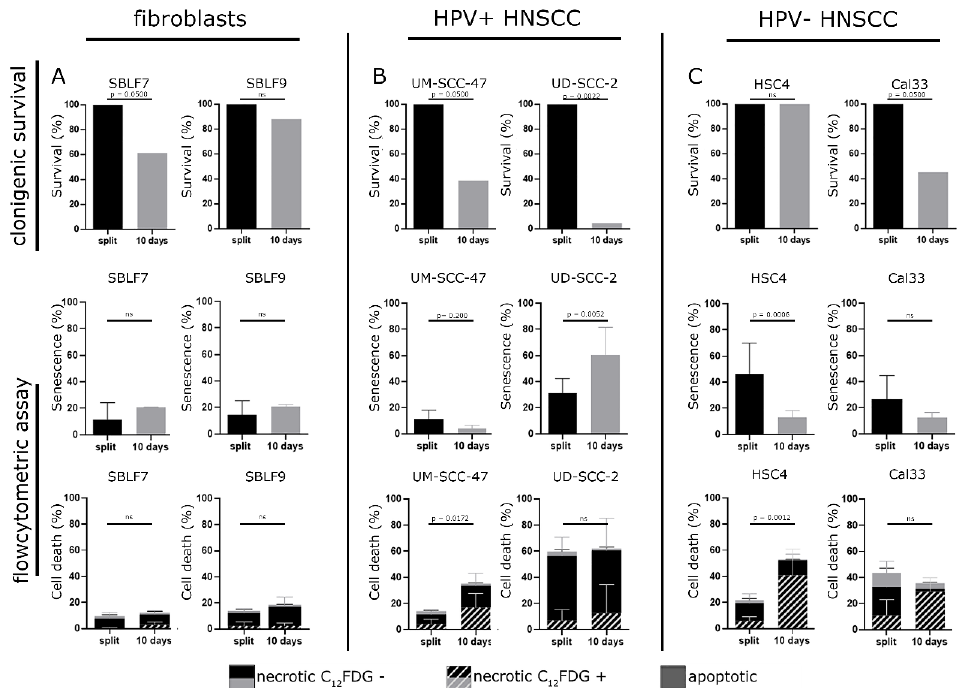
Figure 6. ( A ) First column: fibroblasts, ( B ) second column: HPV + cell lines, ( C ) HPV- cell lines. First row: clonogenic survival of fibroblast cell cultures SBLF7, SBLF9, HPV + HNSCC UM-SCC-47, UD-SCC-2, HPV- HNSCC HSC4, and Cal33. Comparison of regularly passaged cells (split) and cells grown for 11 days on a slide (10 days) before seeding for clonogenic assay. Second row: senescence induction assessed by flow cytometry in regularly passaged cells (split) and cells grown for 11 days on a slide (10 days). Third row: apoptosis and necrosis induction assessed by flow cytometry in regularly passaged cells (split) and cells grown for 11 days on a slide (10 days). Distribution of C 12 FDG positive and C 12 FDG negative cells among the necrotic cells. p -values refer to the whole proportion of